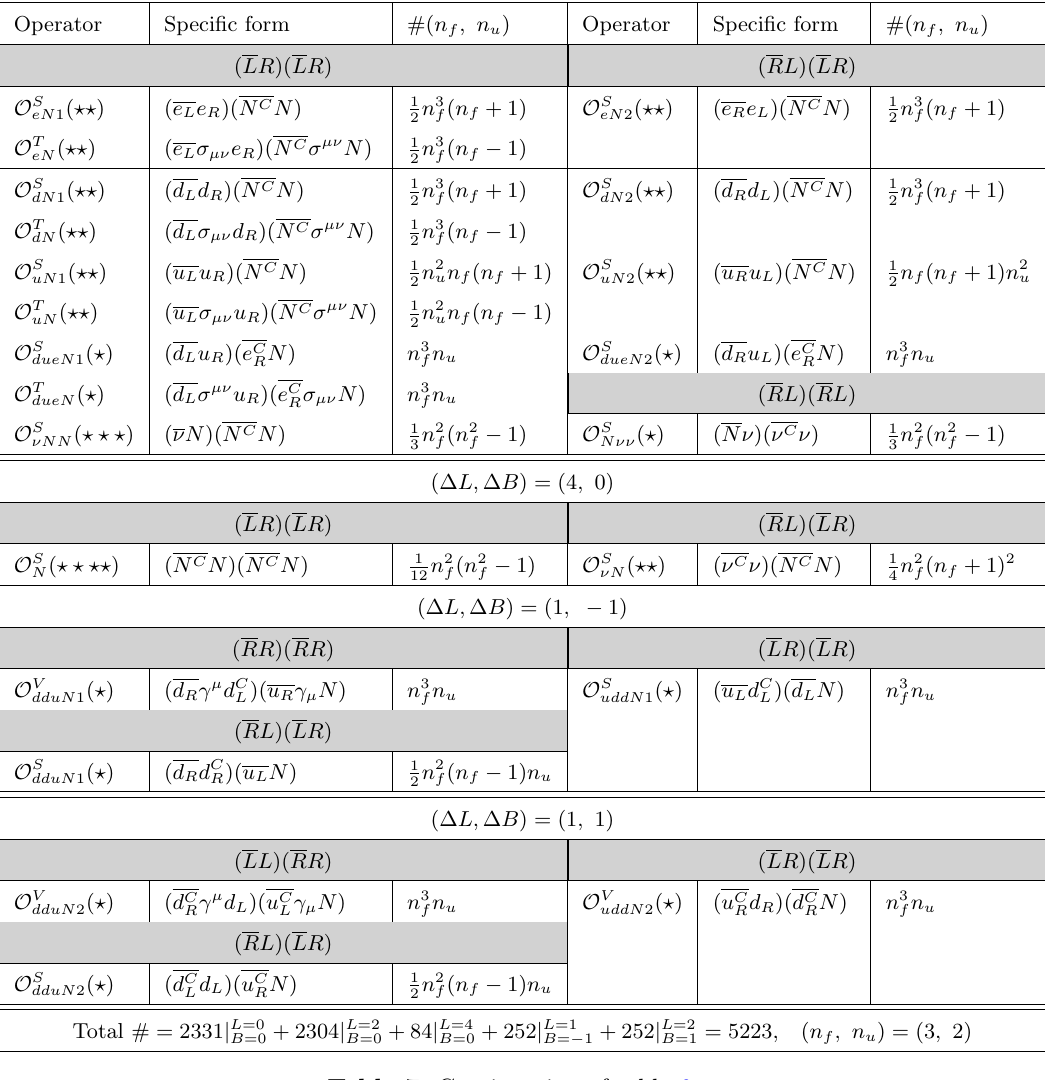
Table 7 . Continuation of table